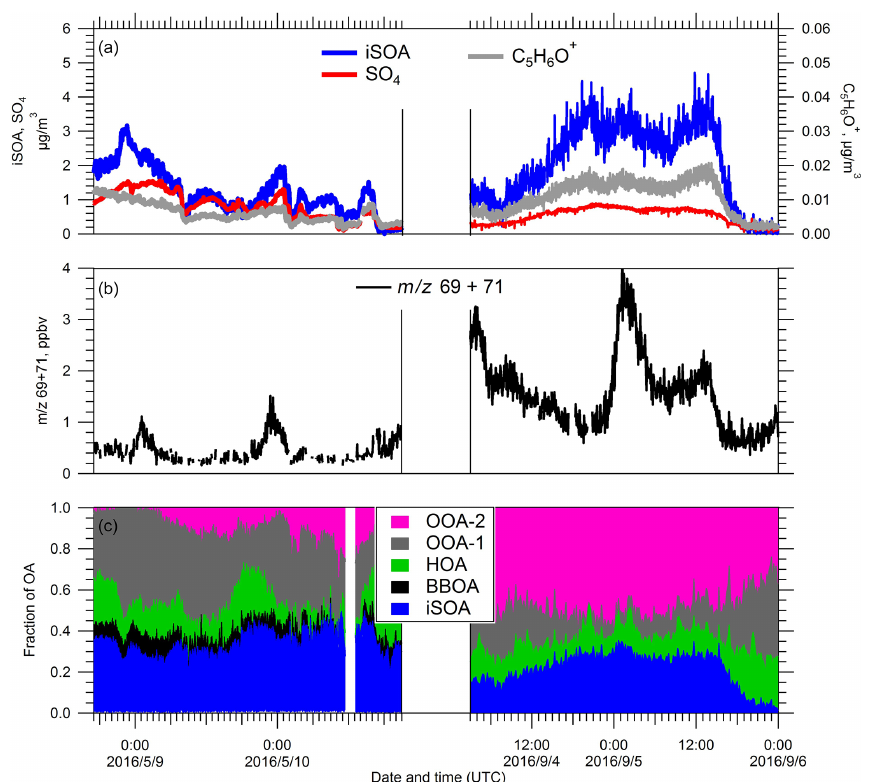
Figure 8. Temporal evolutions of (a) the iSOA PMF factor and SO 4 (left subpanel) and C 5 H 6 O + (right subpanel), (b) the sum of m/z 69 (isoprene) and 71 (first-generation oxidation products of isoprene), and (c) fractional contribution of PMF-resolved factors to the total OA during the two iSOA events in spring and summer IOPs,